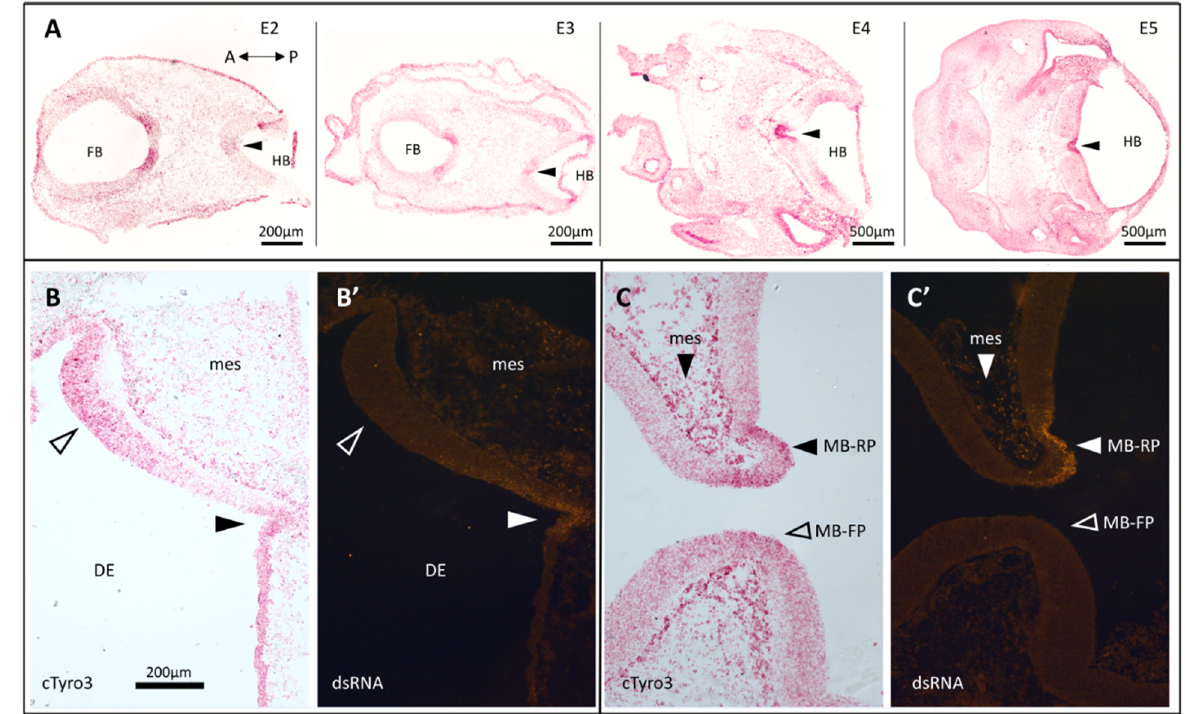
Figure 1. Endogenous cTyro3 mRNA expression pattern in the chick embryonic brain overlaps with known hotspots of ZIKV infection. ( A ) Sections from embryos sampled daily from E2 to E5 stained with cTyro3 mRNA probe using RNAscope in situ hybridization (representative of n = 2–6 per day). cTyro3 expression is strong in regions known to be readily infected with ZIKV, including the floor plate of the hindbrain (closed arrowheads). cTyro3 mRNA expression of a ZIKV-infected E5 embryonic chick brain in ( B ) the diencephalon and ( C ) the midbrain shows regions with overlapping ZIKV infection in alternate sections ( B’ ) and ( C’ ) respectively (closed arrowheads). Surrounding regions that did not show overlap are indicated with open arrowheads. Mesenchyme surrounding the brain, previously shown to be permissive for ZIKV, strongly expresses cTyro3 and, in the ZIKV-infected embryo of panel ( C’ ), is positive for dsRNA. Abbreviations: A, anterior; DE, diencephalon; FB, forebrain; HB, hindbrain; MB-FP, midbrain floor plate; MB-RP, midbrain roof plate; mes, mesenchyme; P, posterior.